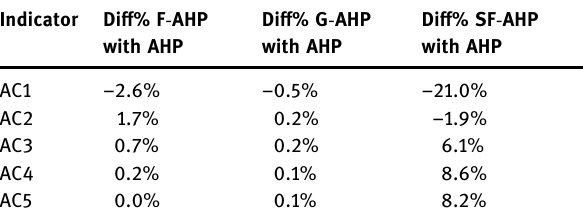
Table 5: F_AHP, G_AHP, and SF_AHP comparative analysis results with AHP